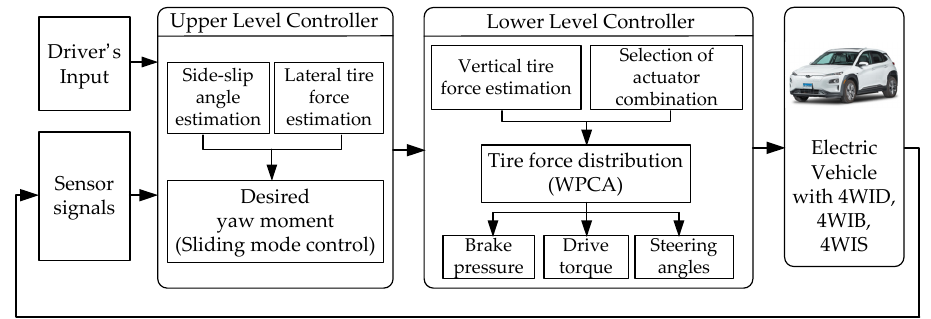
Figure 2. Schematic diagram of the research.